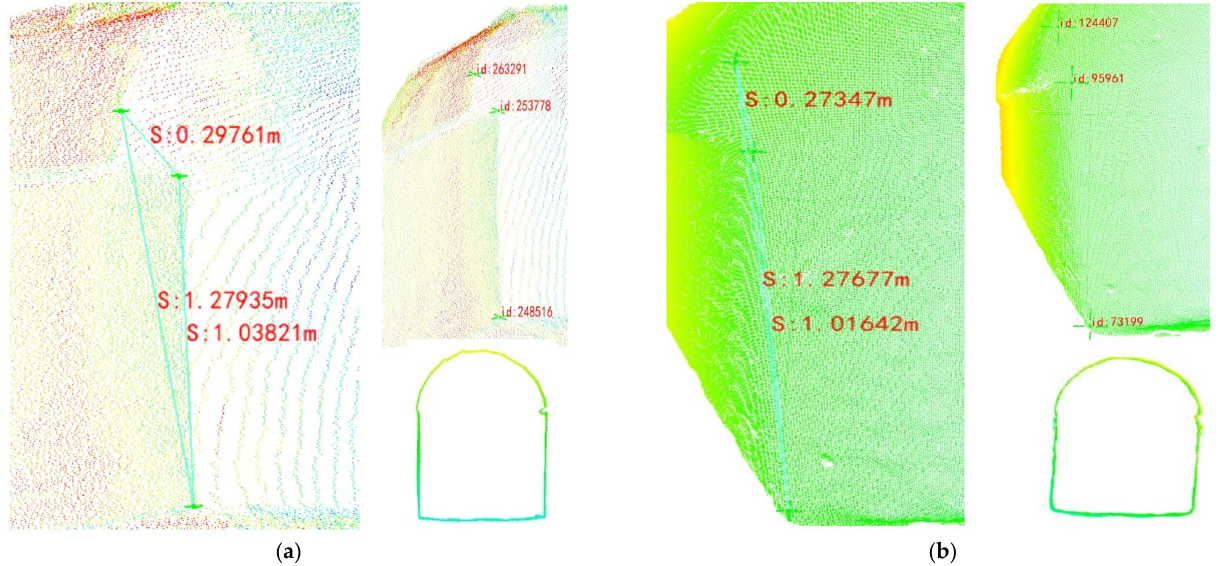
Figure 12. Point cloud data measurement map. ( a ) 3D laser point cloud data measurement; ( b ) Depth camera point cloud data measurement.